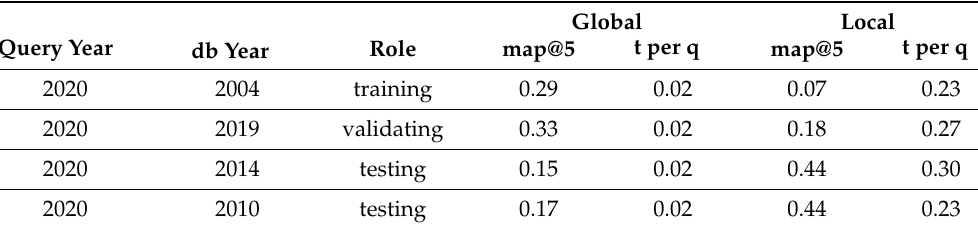
Table 9. The map@5 results for the global and local descriptors, cross-year correspondence learning, cross-source data.